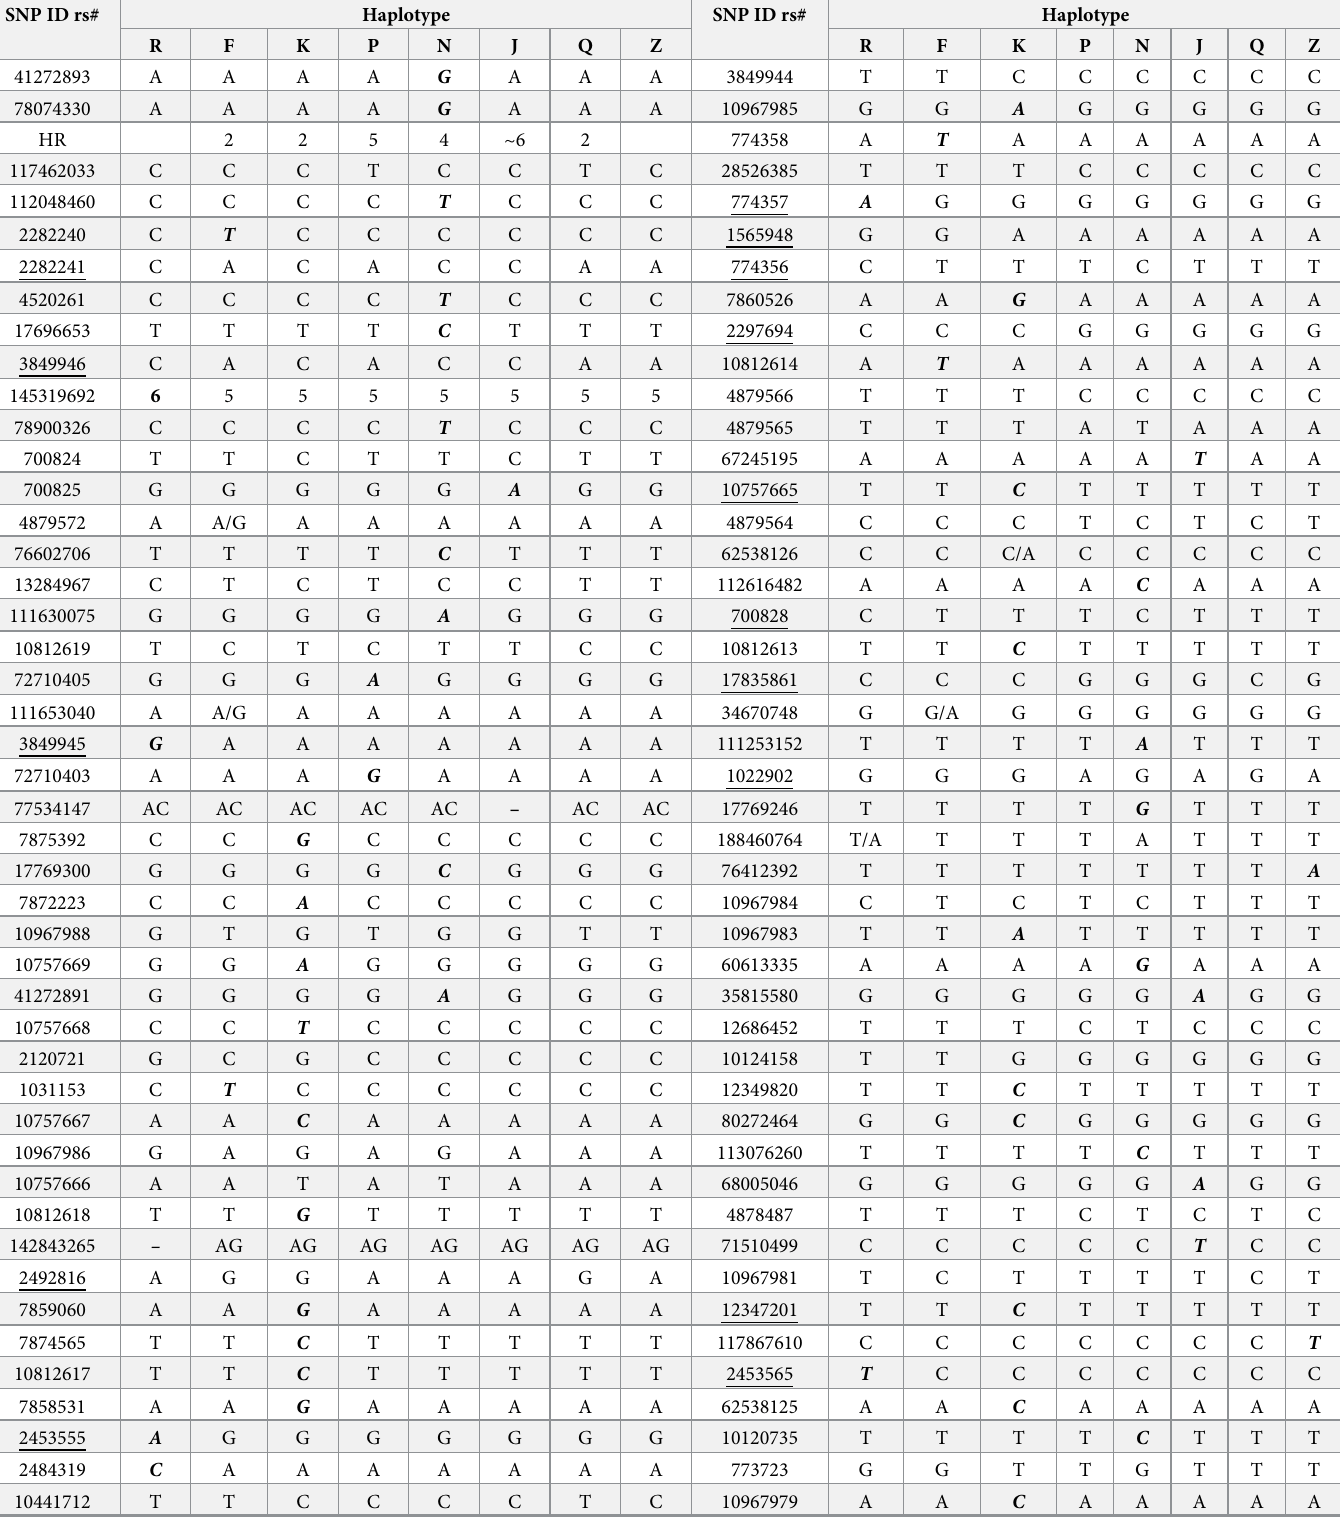
Table 1. Detailed genetic map of the major C9orf72